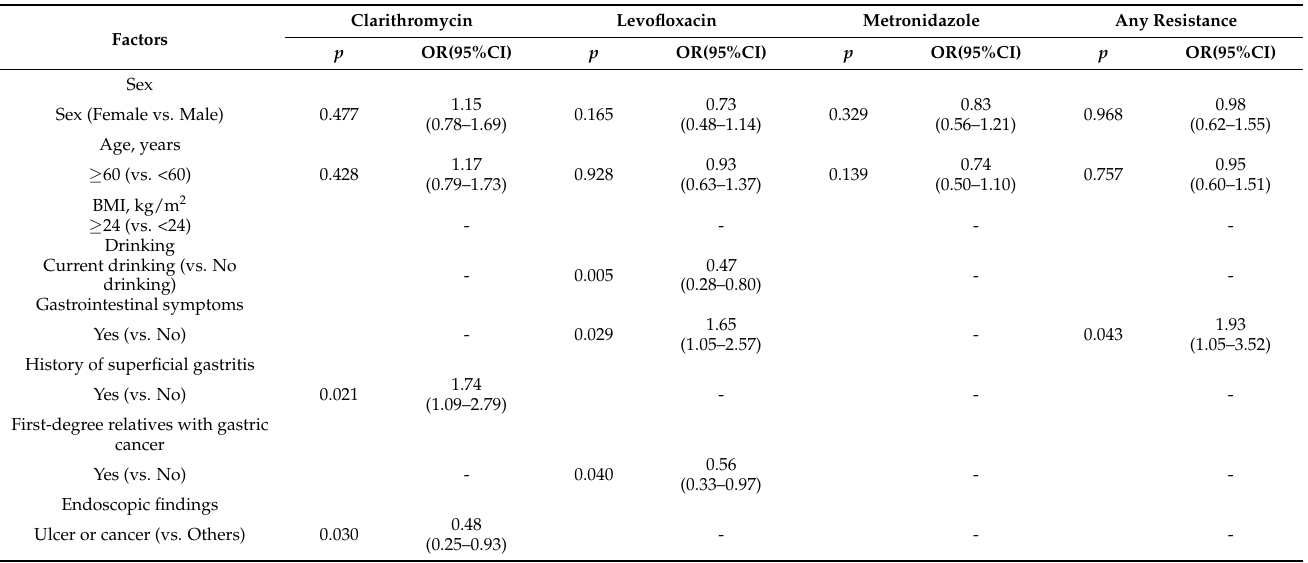
Table 6. Factors associated with the resistance of H. pylori to clarithromycin, levofloxacin, metronida- zole or any antibiotics using multivariable logistic